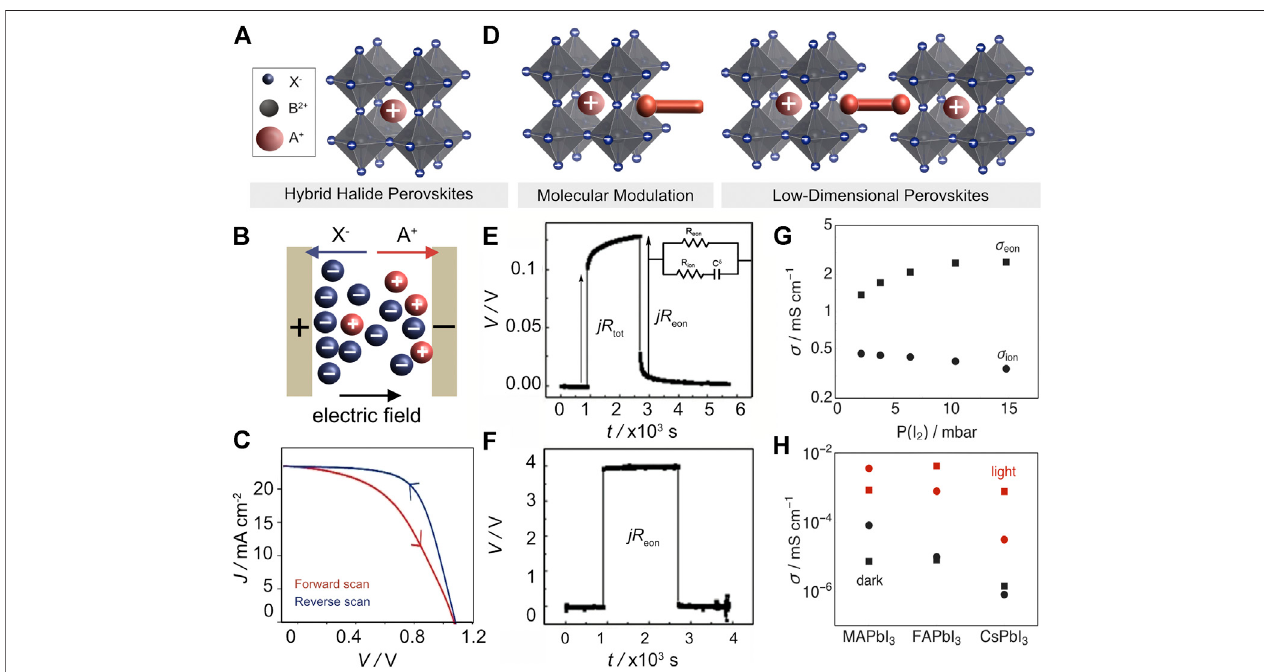
FIGURE1| (A) Structuralrepresentationof3Dperovskitesde fi nedbytheABX 3 formulaillustratedbyacubicstructure. (B) Illustrationofmixedconductivitycausedby ion migration inanelectric fi eld. (C) Hysteresisincurrent-voltagedevicecharacteristicsthatiscommonlyassociatedwithion migration.Basedonthe workpublishedbythe Royal Society of Chemistry (Weber et al., 2018). (D) Schematic of molecular modulation of hybrid perovskites (left) and layered low-dimensional perovskite architectures (right) basedonorganicmoieties(redrods)(GraetzelandMilic ́ ,2019).Thesestructurescancontributetomitigatingthedetrimentaleffectsofionicmotion,e.g.,through interface, grain, and strain engineering. (E,F) Evolution of potential during a galvanostatic (1 nA) polarization measurement of MAPbI 3 in the (E) dark and (F) under light illumination.Insetshowsasimpli fi edcircuitmodelusedtorepresentmixedconductivity,includingelectronicresistance( R eon ),ionicresistance( R ion )andchemicalcapacitance ( C δ ).AdaptedwithpermissionfromWileyVCH(Yangetal.,2015). (G,H) Electronic(square)andionic(circle)conductivitiesunderillumination(red)andinthedark(black)upon (G) iodine partial pressure of MAPbI 3 [Adapted from Nature (Kim et al., 2018)] or (H) other perovskite compositions. Adapted from Wiley VCH (Kim et al., 2020).